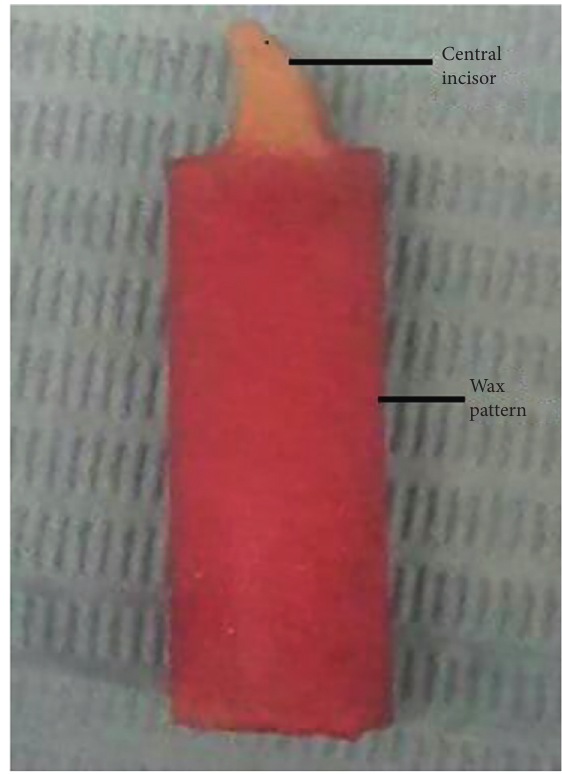
Figure 2: Tested sample